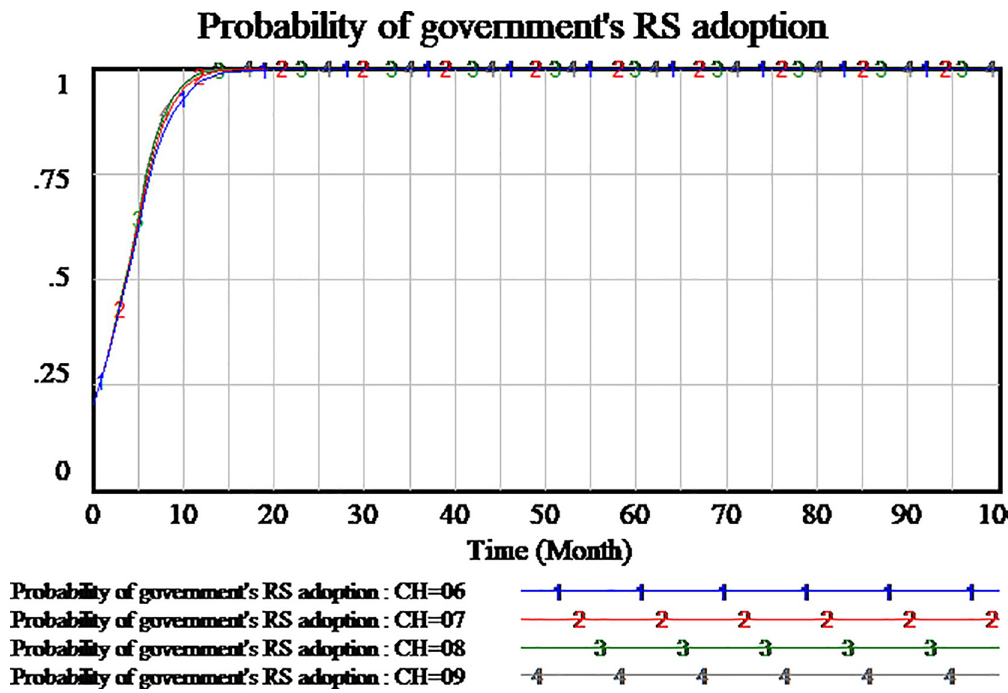
Fig 17. Impact of different cost of high-quality service on government.